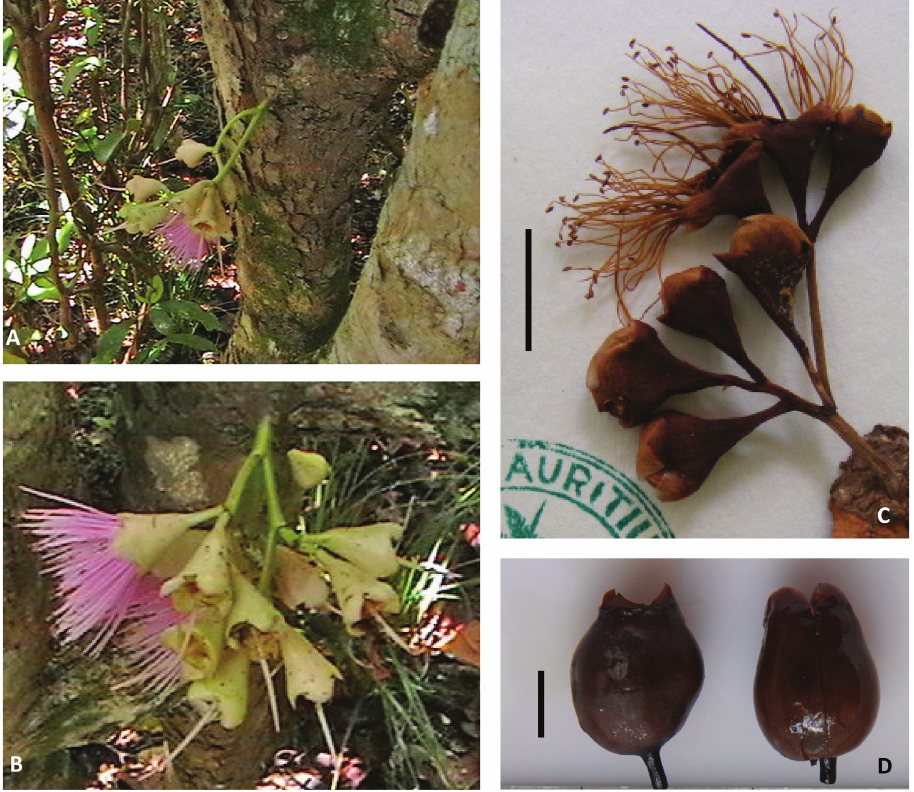
Figure 2. Floral and fruit characters. A and B Sole recorded images of flowering event C Close-up of dried inflorescence D Close-up of two fruits. ( A–C D’Argent & Pynee MAU 25014; D D’Argent & K. Pynee MAU 26448; A and B courtesy of Kersley Pynee). Scale bar = 1